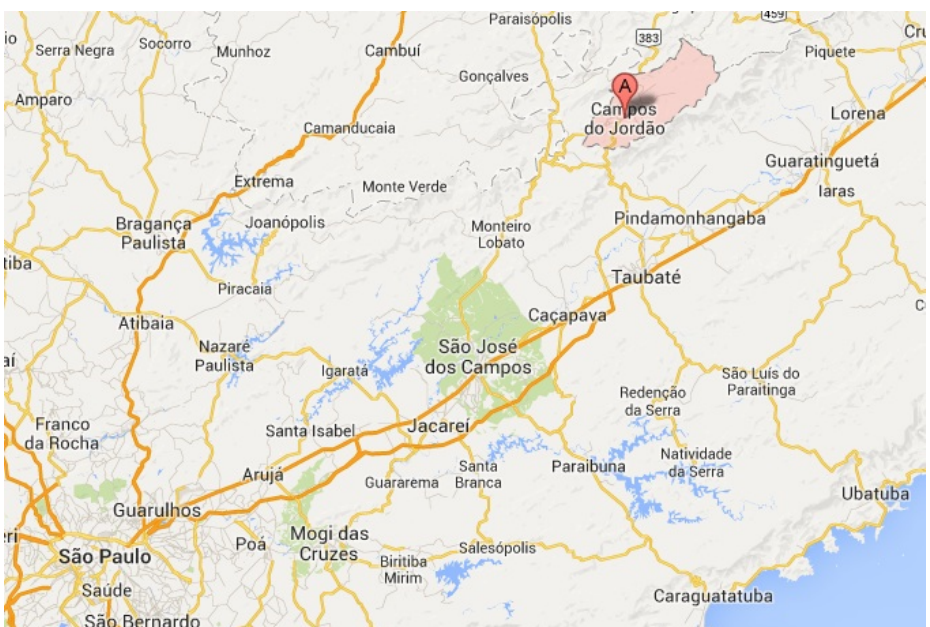
Figure 2. Location of Campos do Jordão city (Red Point). Source: maps.google.com.br, accessed on 10 February